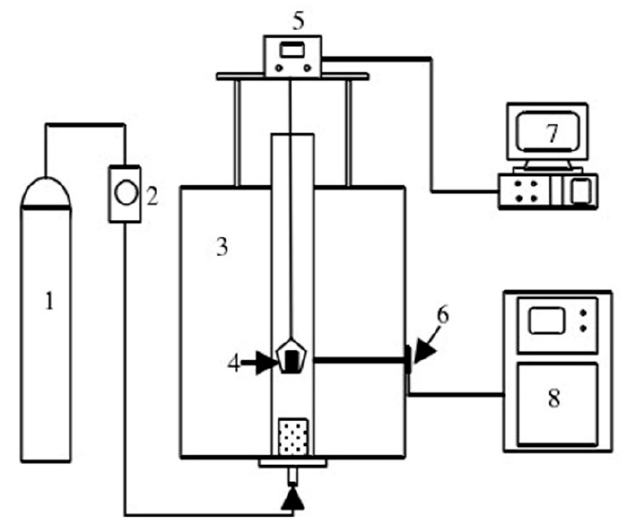
Figure 1. Schematic diagram of the reduction roasting experimental apparatus (1—argon cylinder;